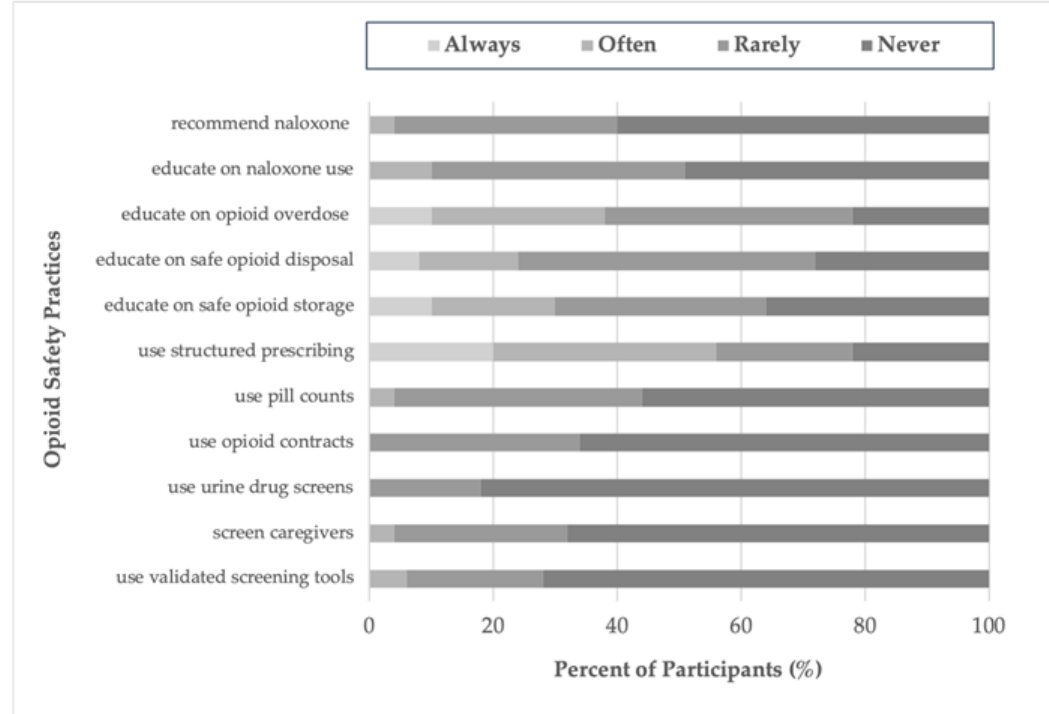
Figure 1. Frequency of opioid safety practices by percentage of participants ( n =